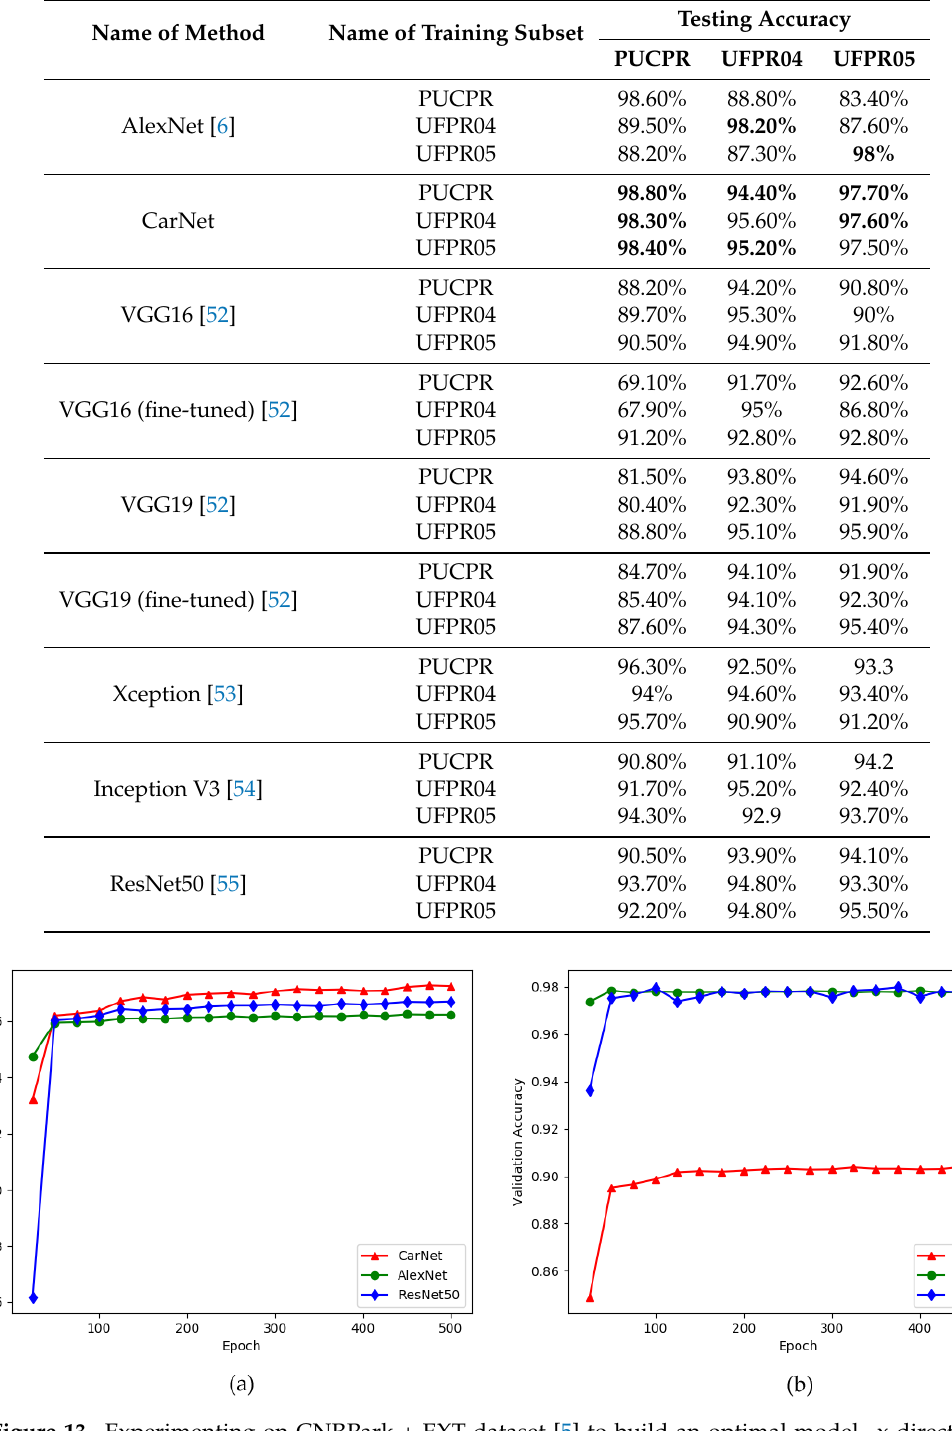
Table 10. Results related to PKLot dataset [4]. Comparison of testing accuracies for Carnet with respect to other models.